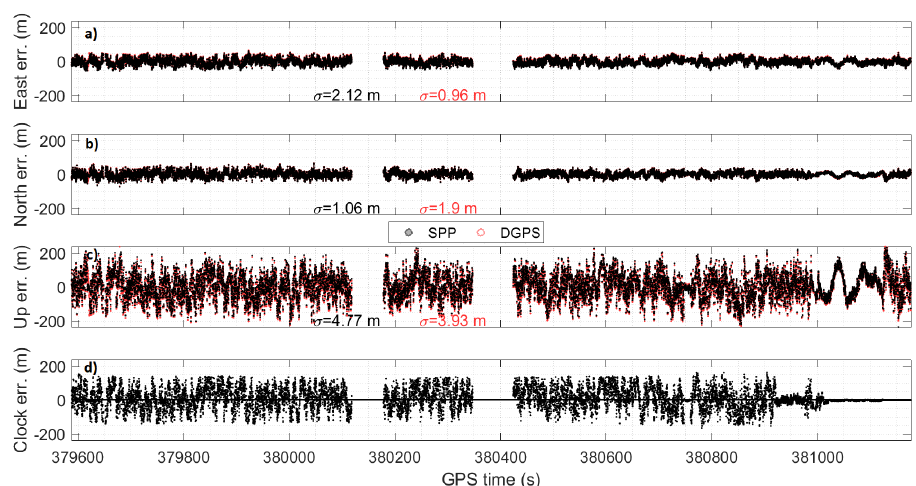
Figure 9. Single-Point (in black) and DGPS (in red) solution components for test 1 (steering on). Panels ( a – d ) show the East, North, Up, and clock bias components, respectively.